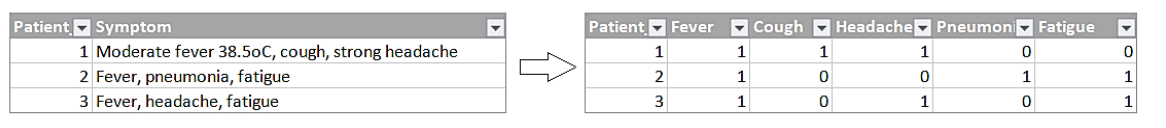
Figure 12. Example of Converting Sentences to Binary Indicators